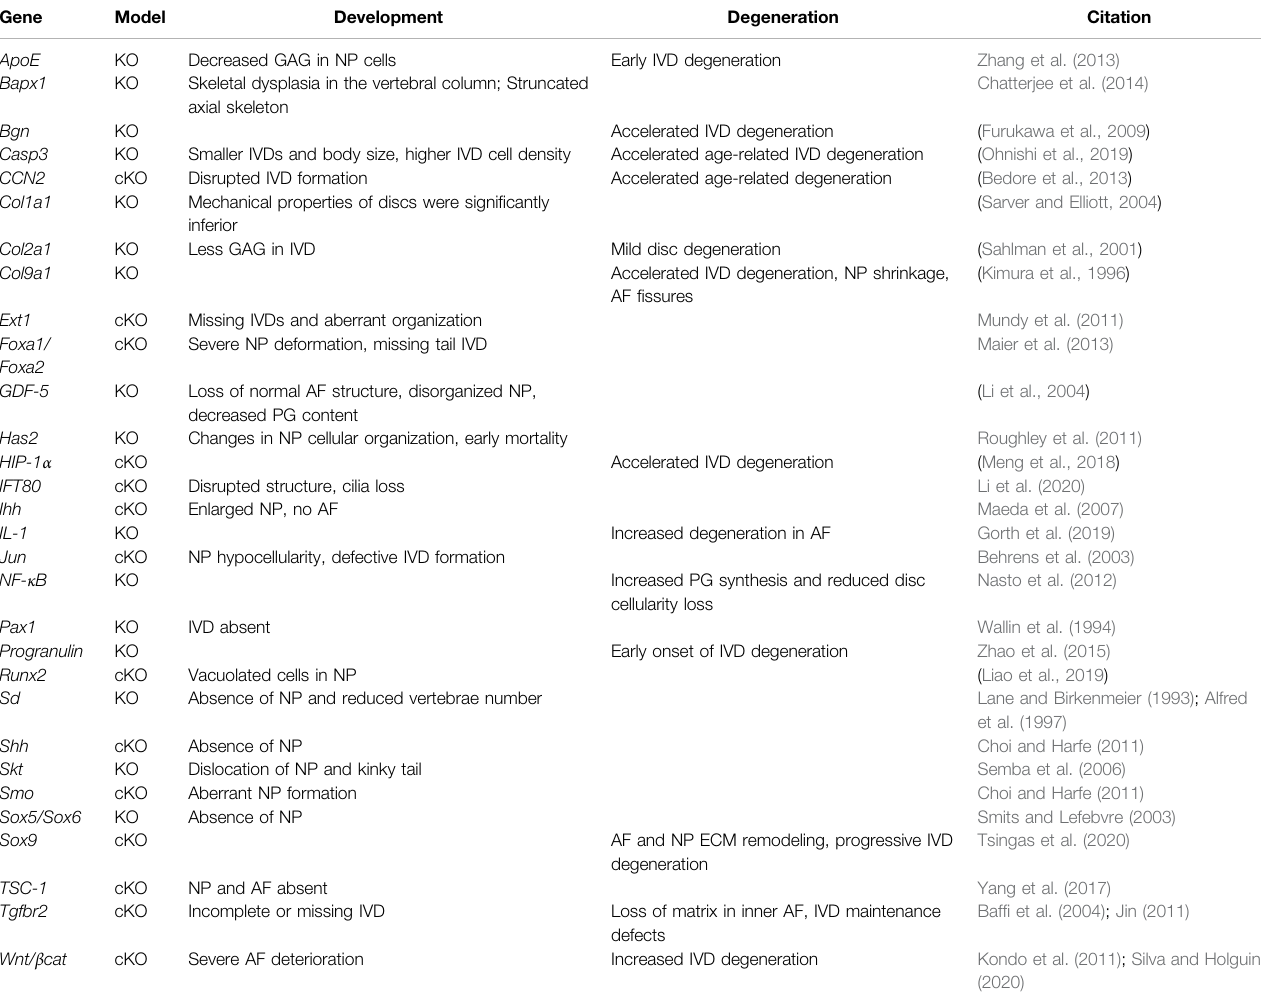
TABLE 1 | Summary of genes and signaling pathways that play an important role in intervertebral disc